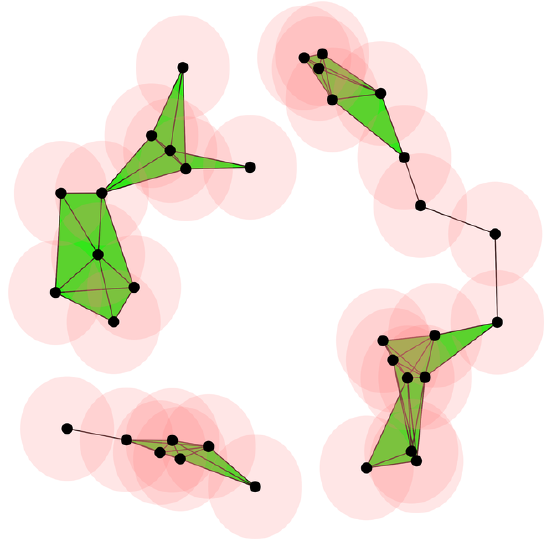
Figure 3 . The Vietoris-Rips complex. Two vertices are connected by an edge if their disks (radius r ) overlap. Higher-dimensional simplices like triangles are included if all of their faces